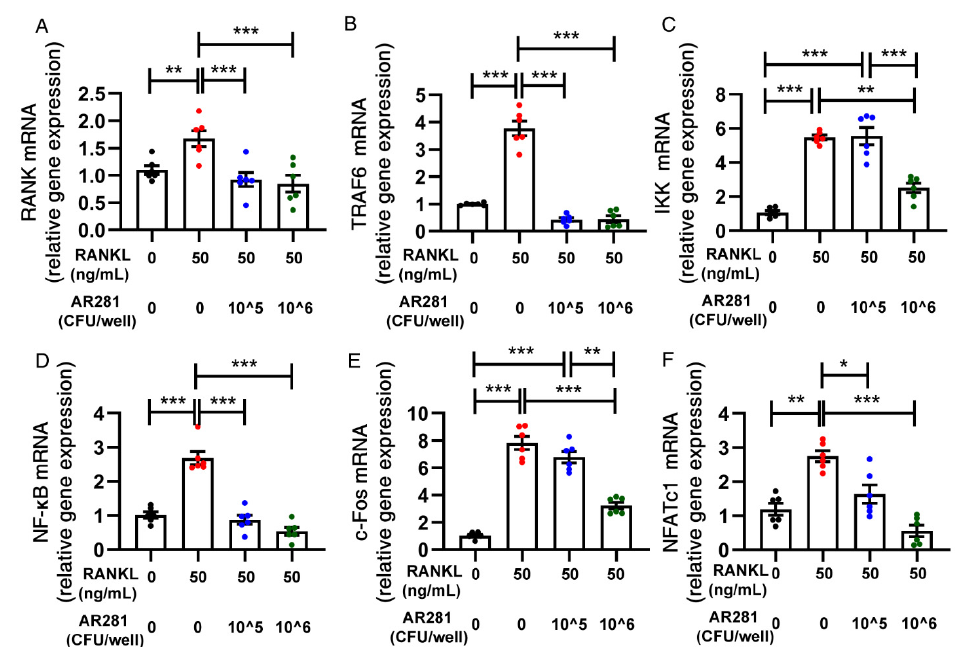
Figure 7. The effects of L. brevis AR281 on the expression profiles of osteoclast differentiation-related markers: ( A ) the expression of RANK; ( B ) TRAF6; ( C ) IKK; ( D ) NF- κ B; ( E ) c-Fos; ( F ) NFATc1. Data are shown as mean ± SEM ( n = 6) and are normally distributed. * p < 0.05, ** p < 0.01, and *** p < 0.001.